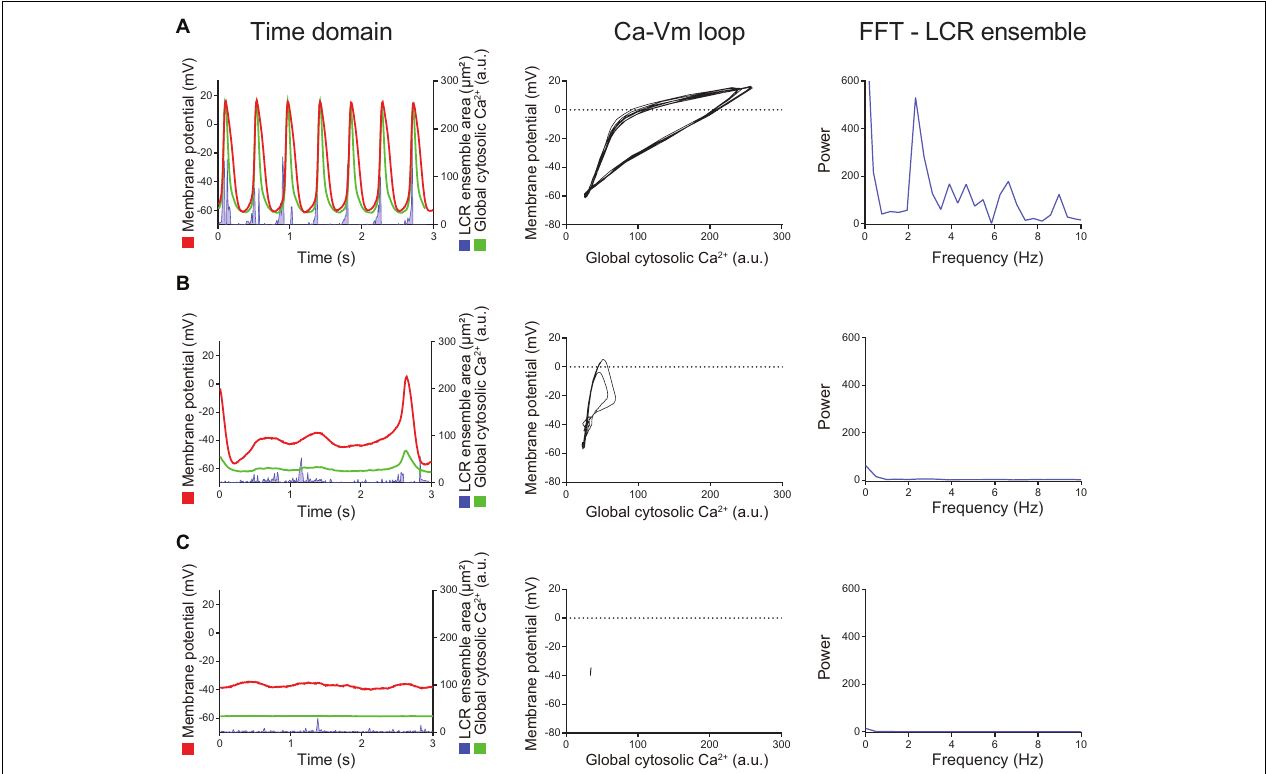
FIGURE 6 | When the intracellular cAMP level decreased by washout of BARs/CPT-cAMP, the changes described in Figure 5 reversed in order. Compared to the steady state AP firing (panel A ), the AP cycle length is prolonged and LCR ensemble is decreased (panel B ), suggesting the disengagement of M- and Ca 2 + -clocks. Shortly after cAMP washout (the panel B ), spontaneous AP firing ceased, and the cell returned to dormant state again (panel C ) in which the membrane potential drifted around –40 mV, ensemble LCR signal area decreased, and the voltage-Ca 2 + loop demonstrated only very small fluctuation around one point, rather than crating a